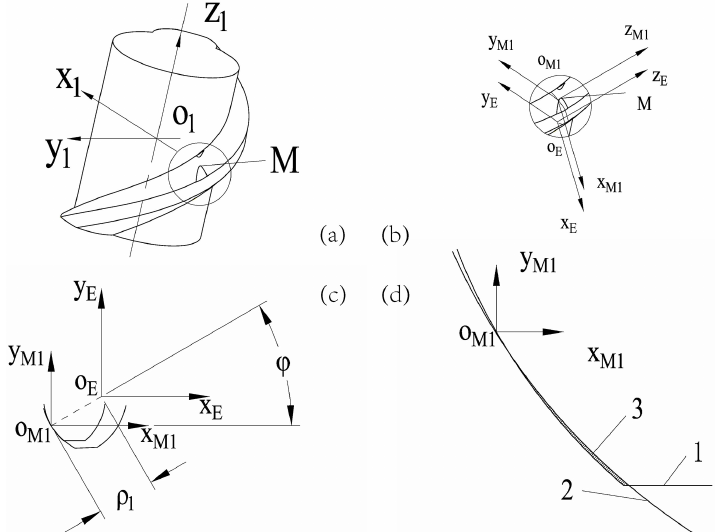
Figure 7. Diagram of the tooth profiles interference of the driving line gear and the driven line gear. (1 – the tooth profile arc of the driving line gear; 2 – the tooth profile arc of driven line gear on the normal plane of the contact curve of the driving line gear; 3 – an interference